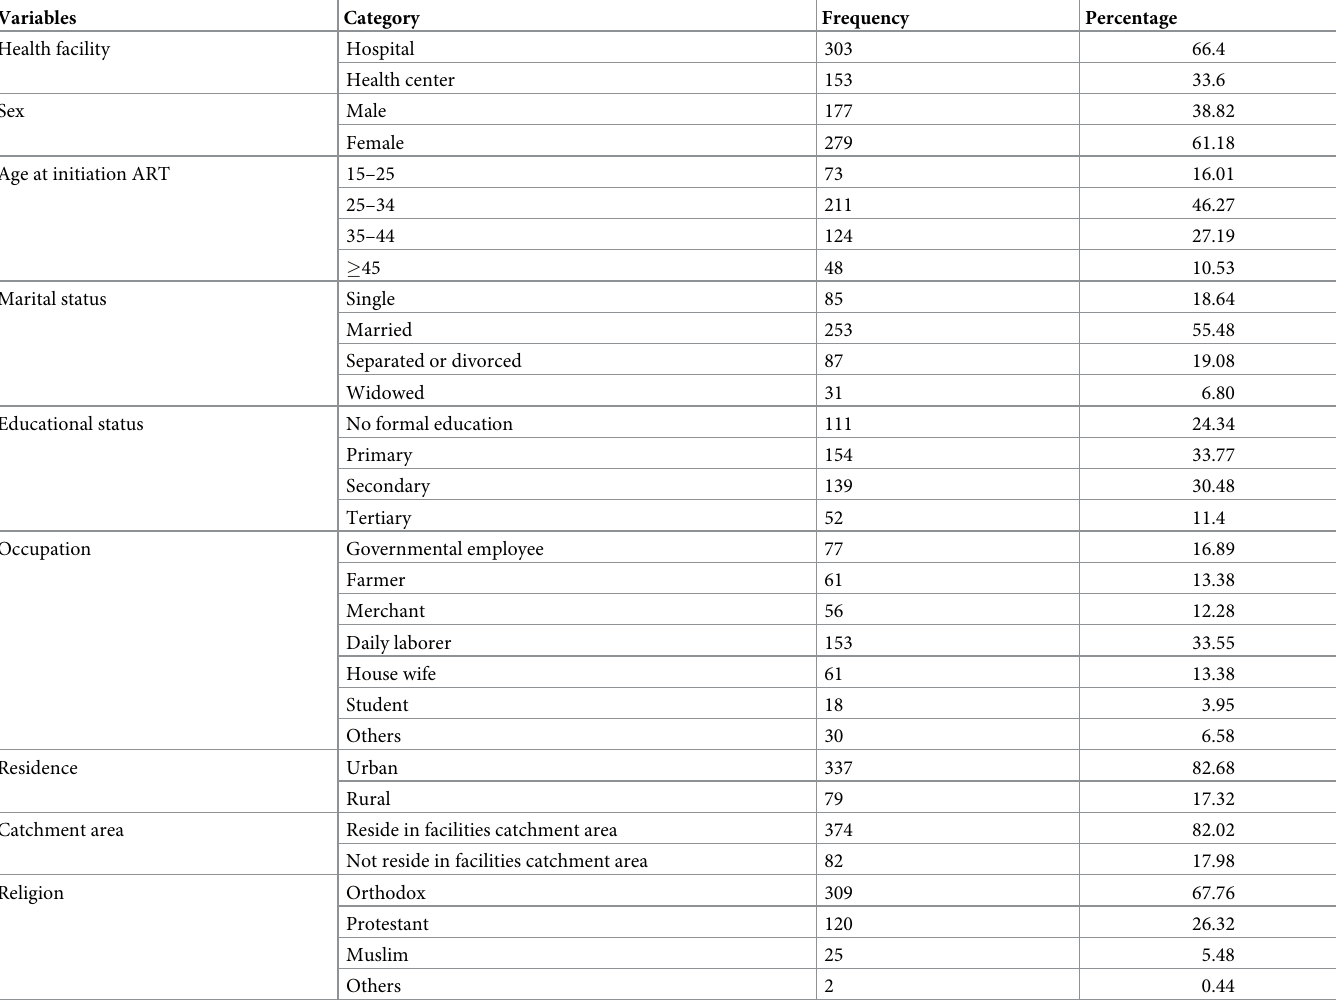
Table 1. Socio-demographic characteristics of HIV positive adults at initiation of HAART in Arba Minch town public health facilities from January 2013 to Decem- ber 2018 (N = 456).